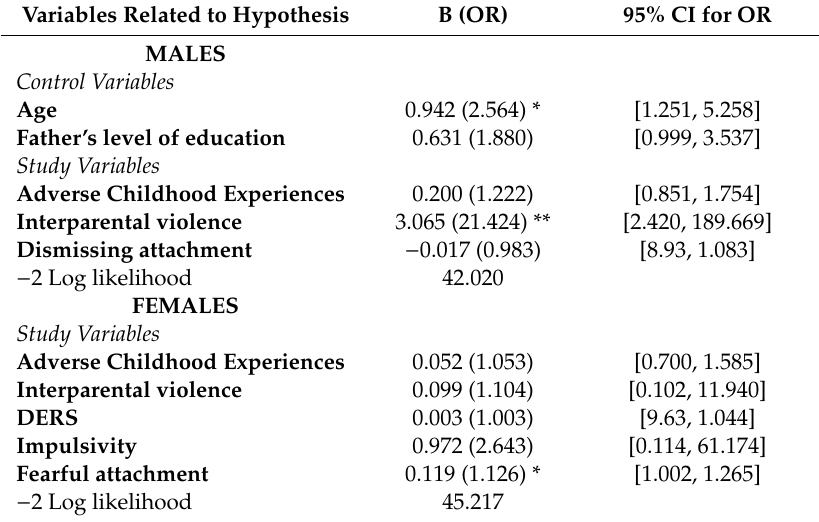
Table8. Logisticregression: RelationshipbetweenstudyvariablesandseverephysicalTDVperpetration in males and